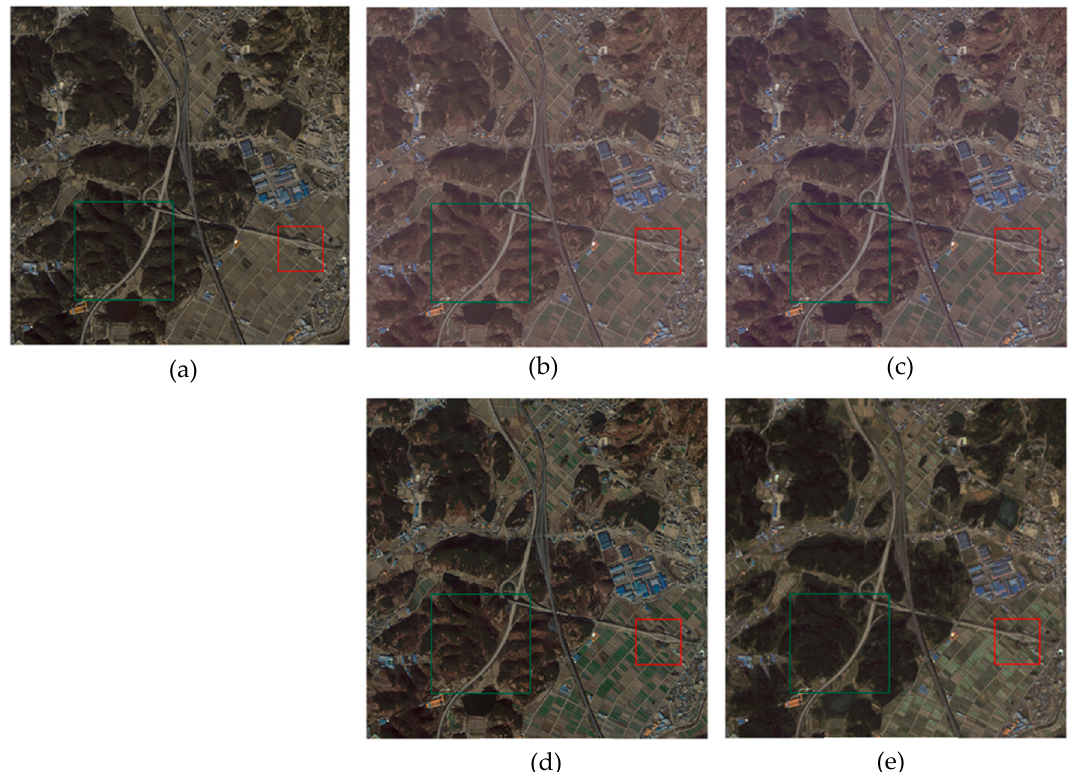
Figure 6. Comparison with the results of relative radiometric normalization for site 1: ( a ) proposed